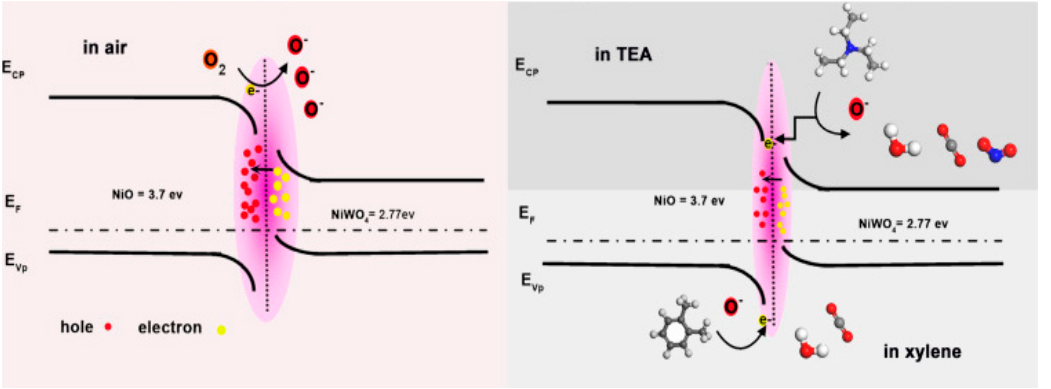
Figure 13. A schematic diagram of the improved gas-sensing mechanism of p-p NiWO 4 decorated NiO [104].